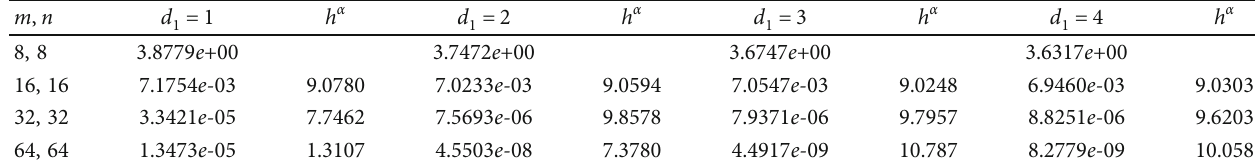
= 7 at t = 1 for Chebyshev nodes. 2